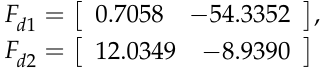
= δ= = δ= and 1.4 . and 1.4 .